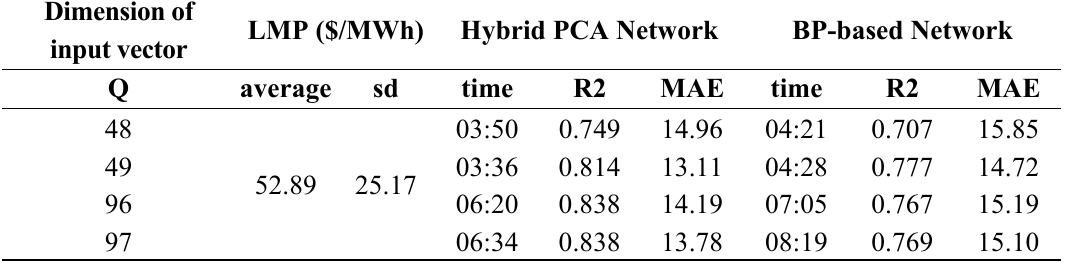
Table 1. Performance comparison between the proposed hybrid PCA and BP-based neural network (Fisk, spring).